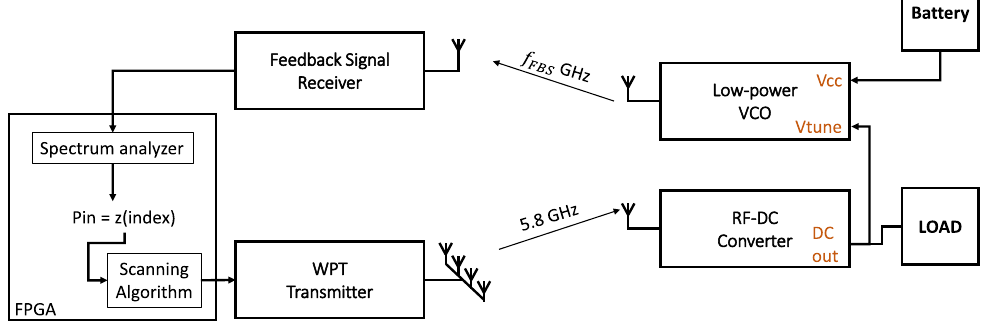
Figure 4. Feedback Channel Block